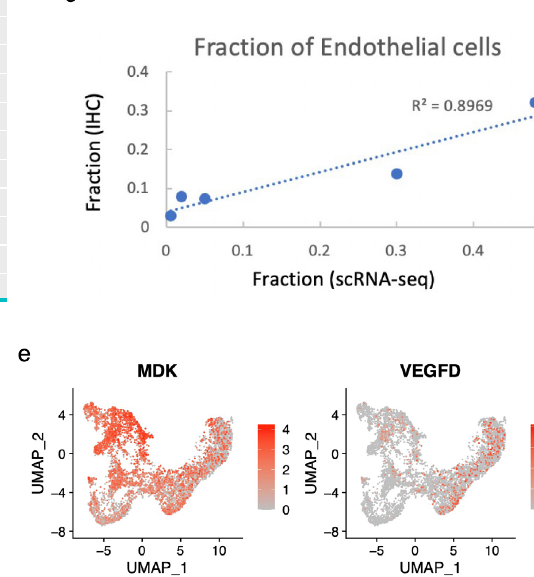
Fig.4|EndothelialcellremodelinginSLS-dominanttumors.a PercentageofSLS and IS cells in the six AML tumors pro fi led. b Quanti fi cation of fractional repre- sentation of blood endothelial cells (BEC) and lymphatic endothelial cells (LEC) in SLS-dominant ( n =4) and IS-dominant tumors ( n =2). c Comparison of